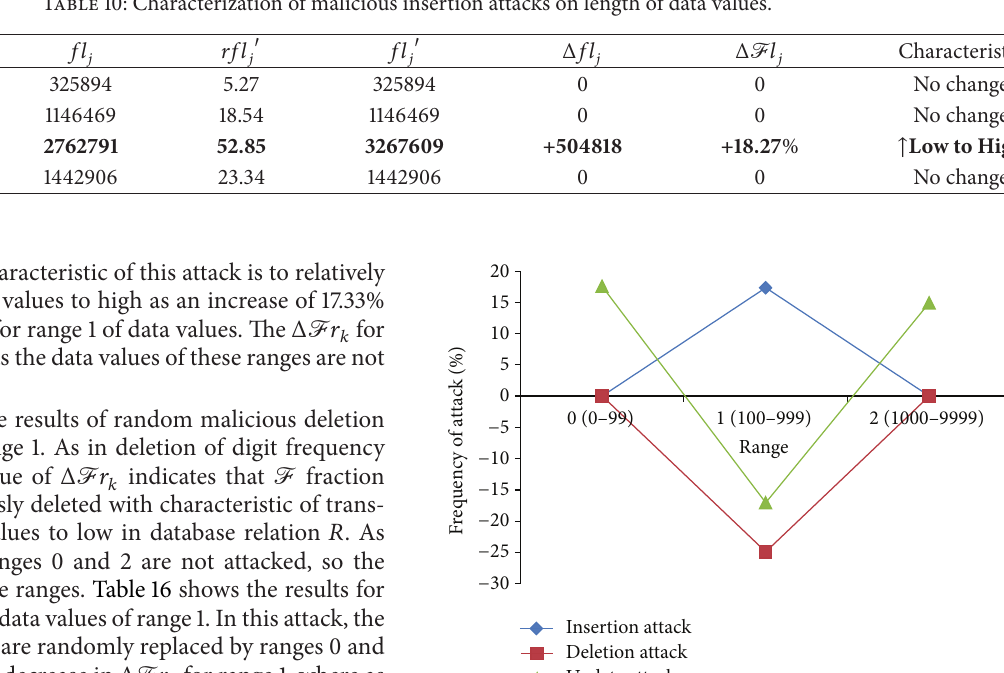
Table 10: Characterization of malicious insertion attacks on length of data values.